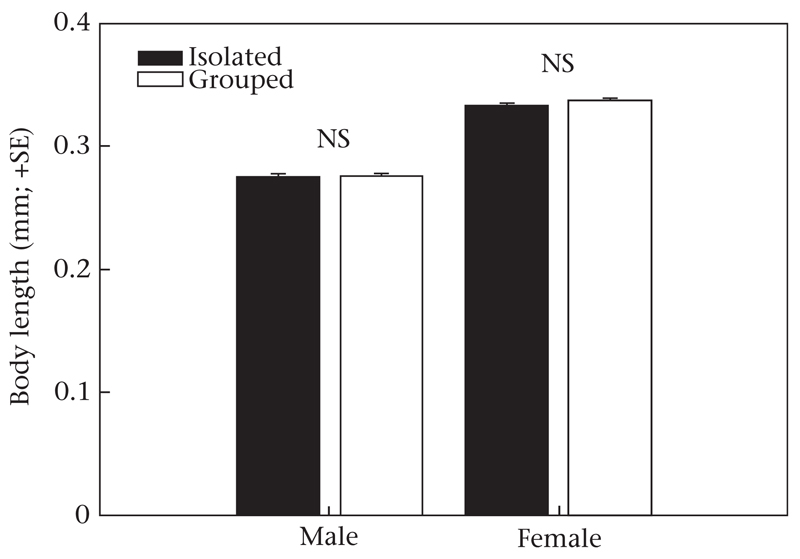
Body length at maturity of male and female P. persimilis that had been socially deprived (reared in isolation until adult) or socially enriched (reared in a conspecific group) (experiment 2). GLM: P > 0.05.